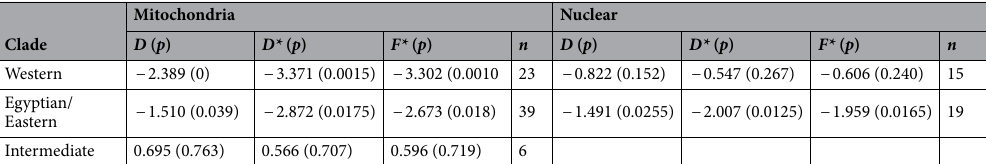
Table 4. Selective neutrality test results on mitochondrial and nuclear segments. D : Tajima’s D ; D * and F *: Fu and Li’s D * and F *.